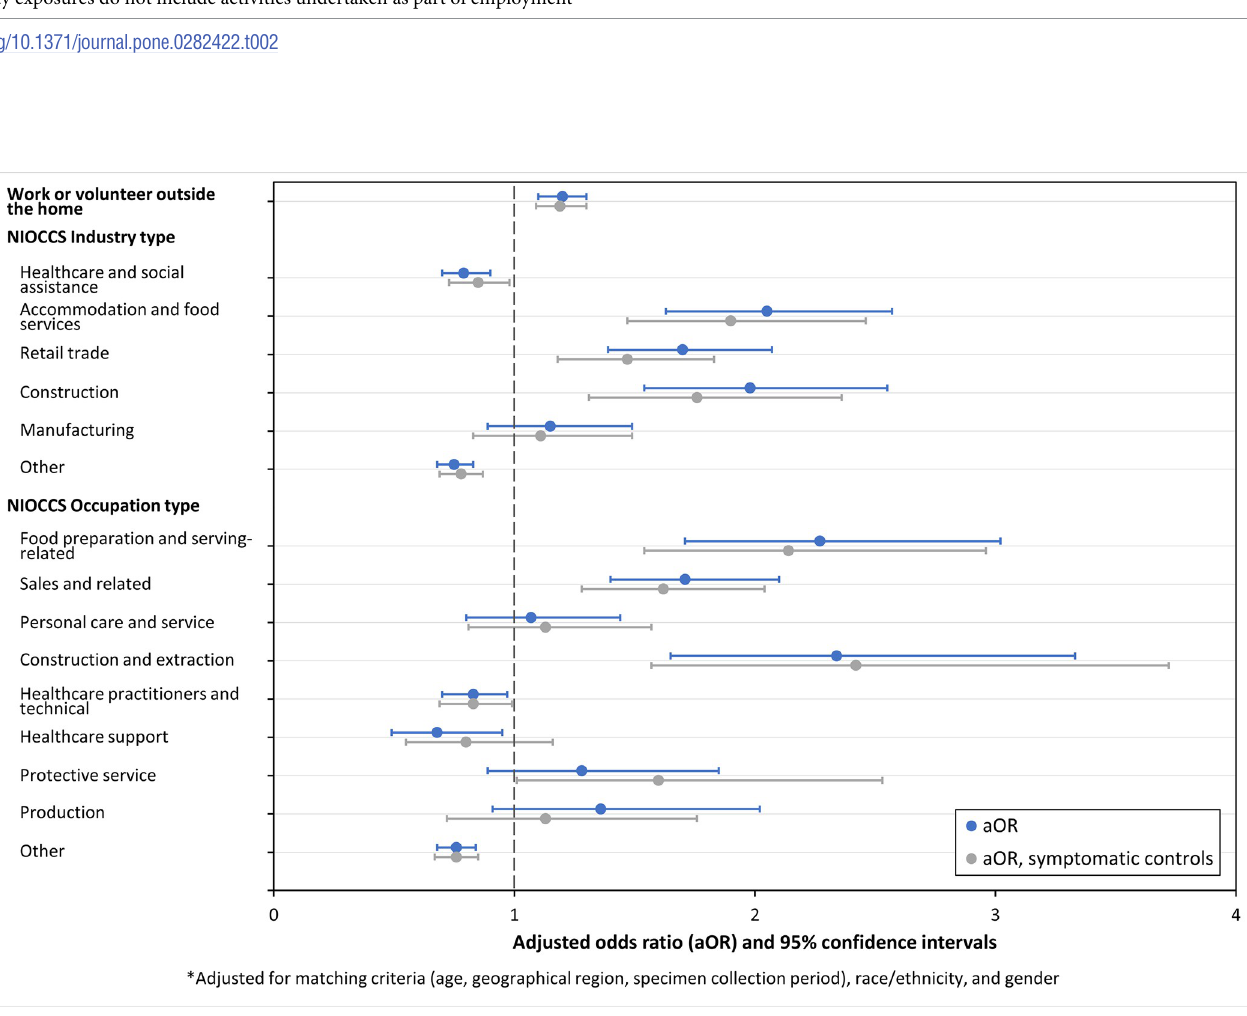
Fig 2. Adjusted odds ratio (aOR) � and 95% confidence intervals for occupations and industries associated with confirmed COVID-19 among symptomatic Colorado adults aged � 18 years–specimen collection dates from March 16 to December 23, 2021. � Adjusted for matching criteria (age, geographical region, specimen collection period), race/ethnicity, and